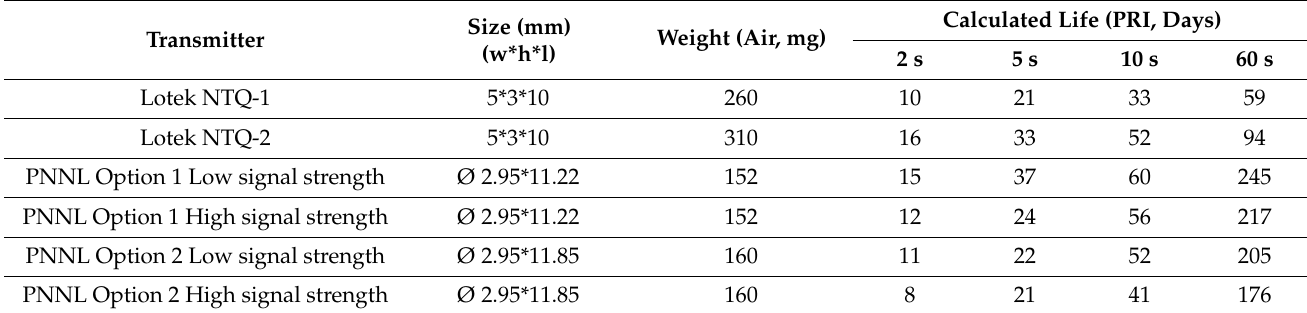
Table 2. Comparison of Lotek and PNNL Prototype